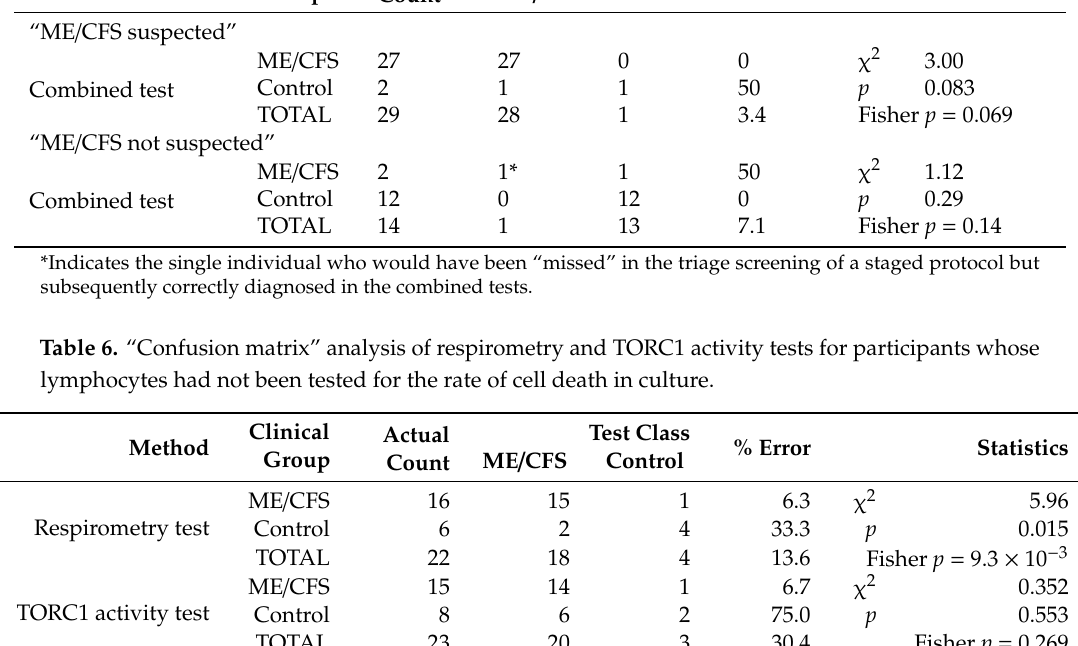
Figure 7. Box plots showing the distribution of logistic regression propensity scores for individuals from whom the fraction of dead lymphocytes after 48 h in culture would have tested as “ME / CFS suspected” or “ME / CFS not suspected”. NA refers to individuals for whom we have respirometry or TORC1 activity but not lymphocyte death rates. Propensity scores from ( a ) five key parameters of lymphoblast respiration, and ( b ) the TORC1 activity are plotted for each individual. In panel ( c ) the propensity scores from all three tests combined are shown. The regression coe ffi cients were as indicated in Figures 4–6, respectively. The boxes show the median and the 25 th and 75 th percentiles, so that the height of the box is the interquartile range (IQR). The whiskers extend to the most extreme observations (largest and smallest) falling within ± 1.5 × IQR of the box. Each point represents a single individual. Scores greater than 0.5 lead to classification of a sample as ME / CFS in the corresponding “confusion matrix”. Table 5. “Confusion matrix” analysis of combined tests for participants whose lymphocytes had been tested for the rate of cell death in culture. Method.